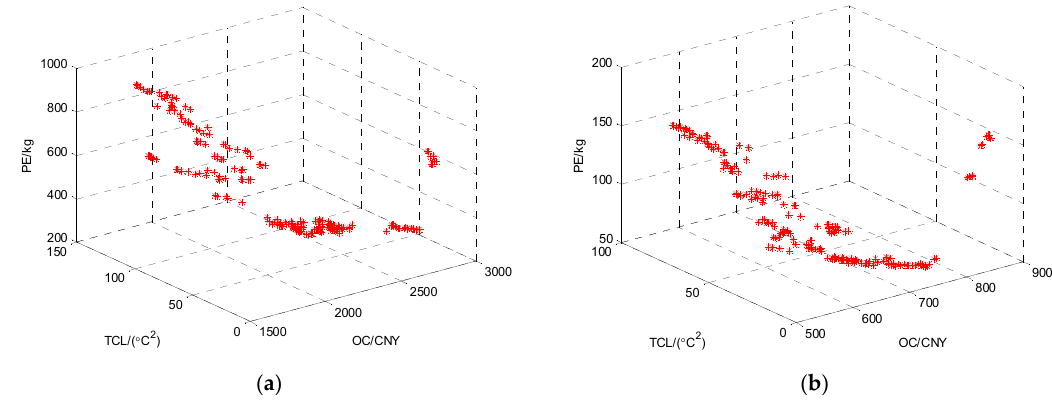
Figure 11. Pareto front of optimal scheduling for RR-microgrid with CHCS. ( a ) A typical day in winter; and ( b ) a typical day in summer.